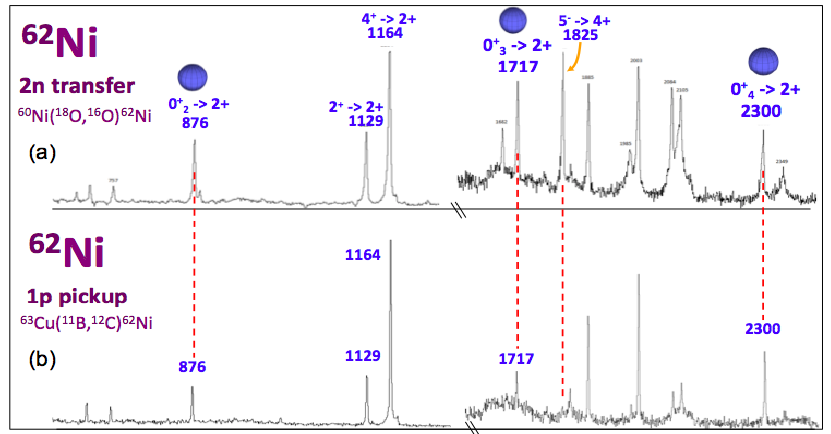
Figure 4. Portions of γ spectra of 62 Ni, as obtained from the two-neutron transfer reaction 60 Ni( 18 O, 16 O) 62 Ni (a) and the proton pick-up reaction 63 Cu ( 11 B, 12 C ) 62 Ni (b) (both performed at beam energies ∼ 1 MeV below the Coulomb barrier energy), focusing on the transition energy region where the decay from the first three excited 0 + states is expected. A clear difference in population pattern is generally observed, with strong suppression of transitions from negative parity states, in the case of the proton pick-up reaction (see for example the 1825-keV 5- à 4+ decay).